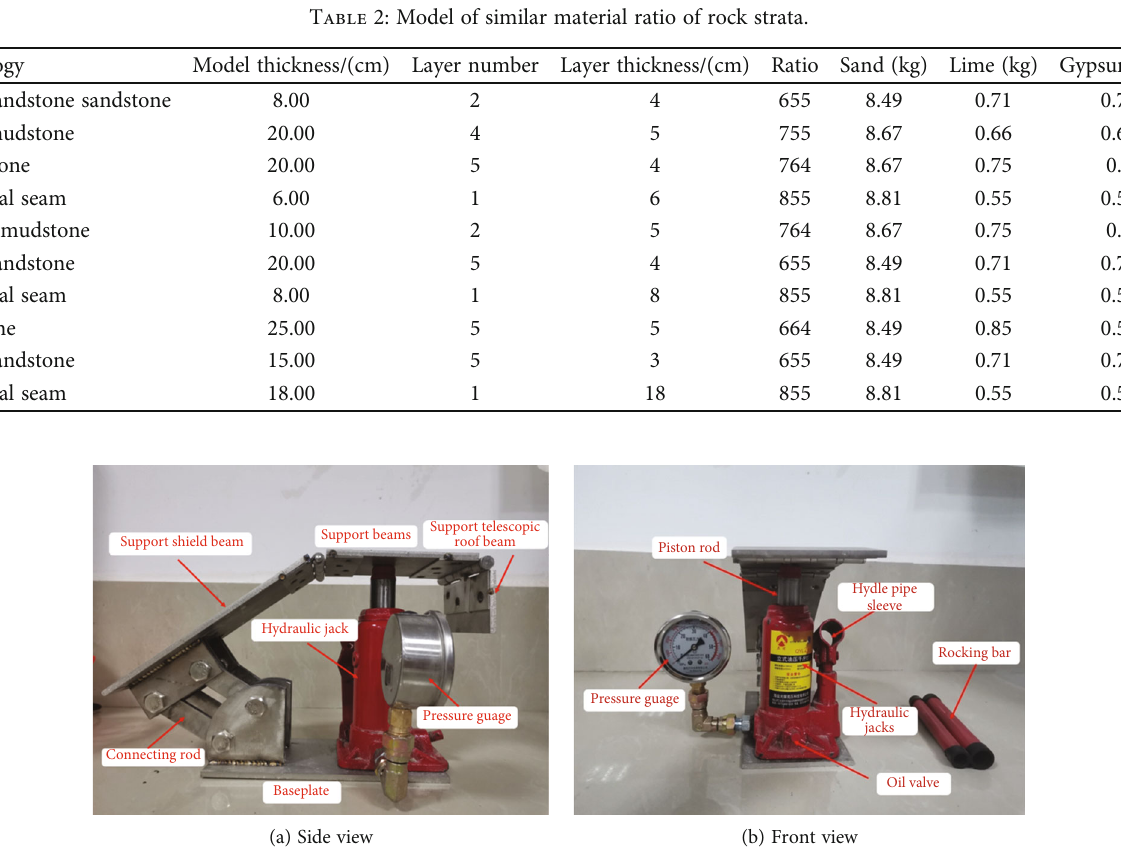
Figure 3: Model of hydraulic